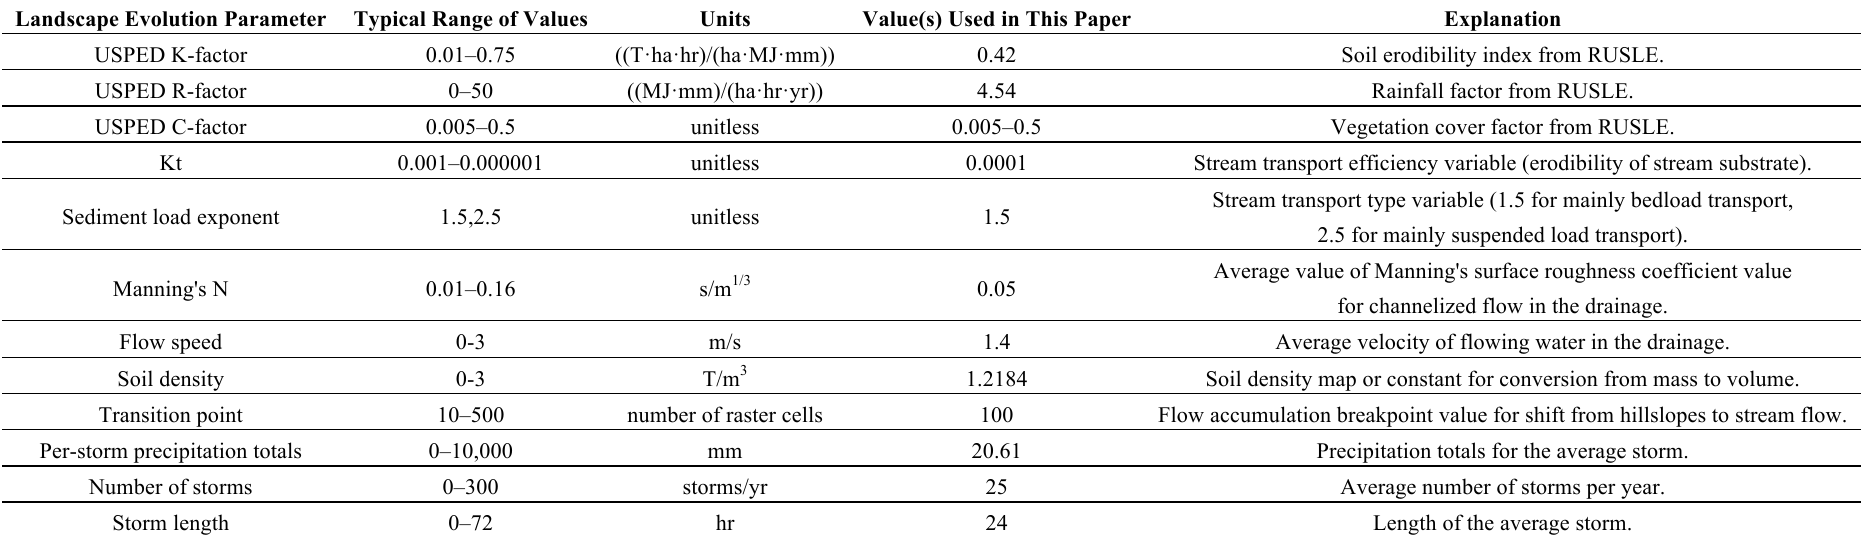
Table A1. Table of landscape evolution parameters used in the surface process modeling component of the MML.